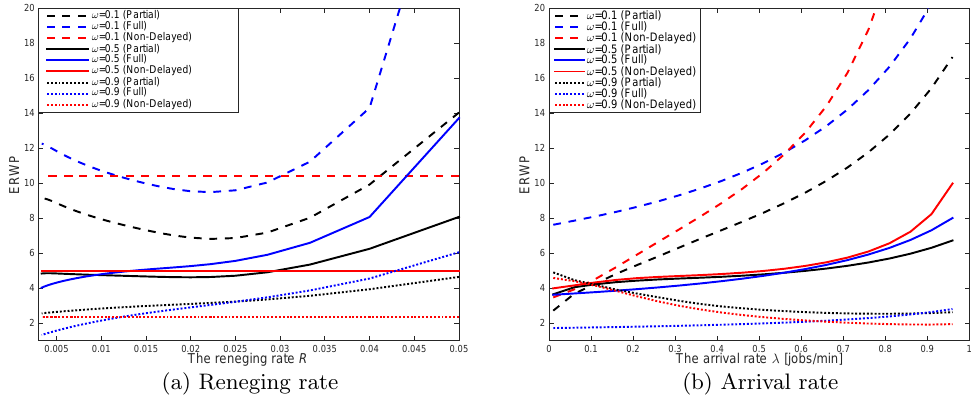
Figure 10: Comparison of ERWP for the offloading models under different reneging rates and arrival